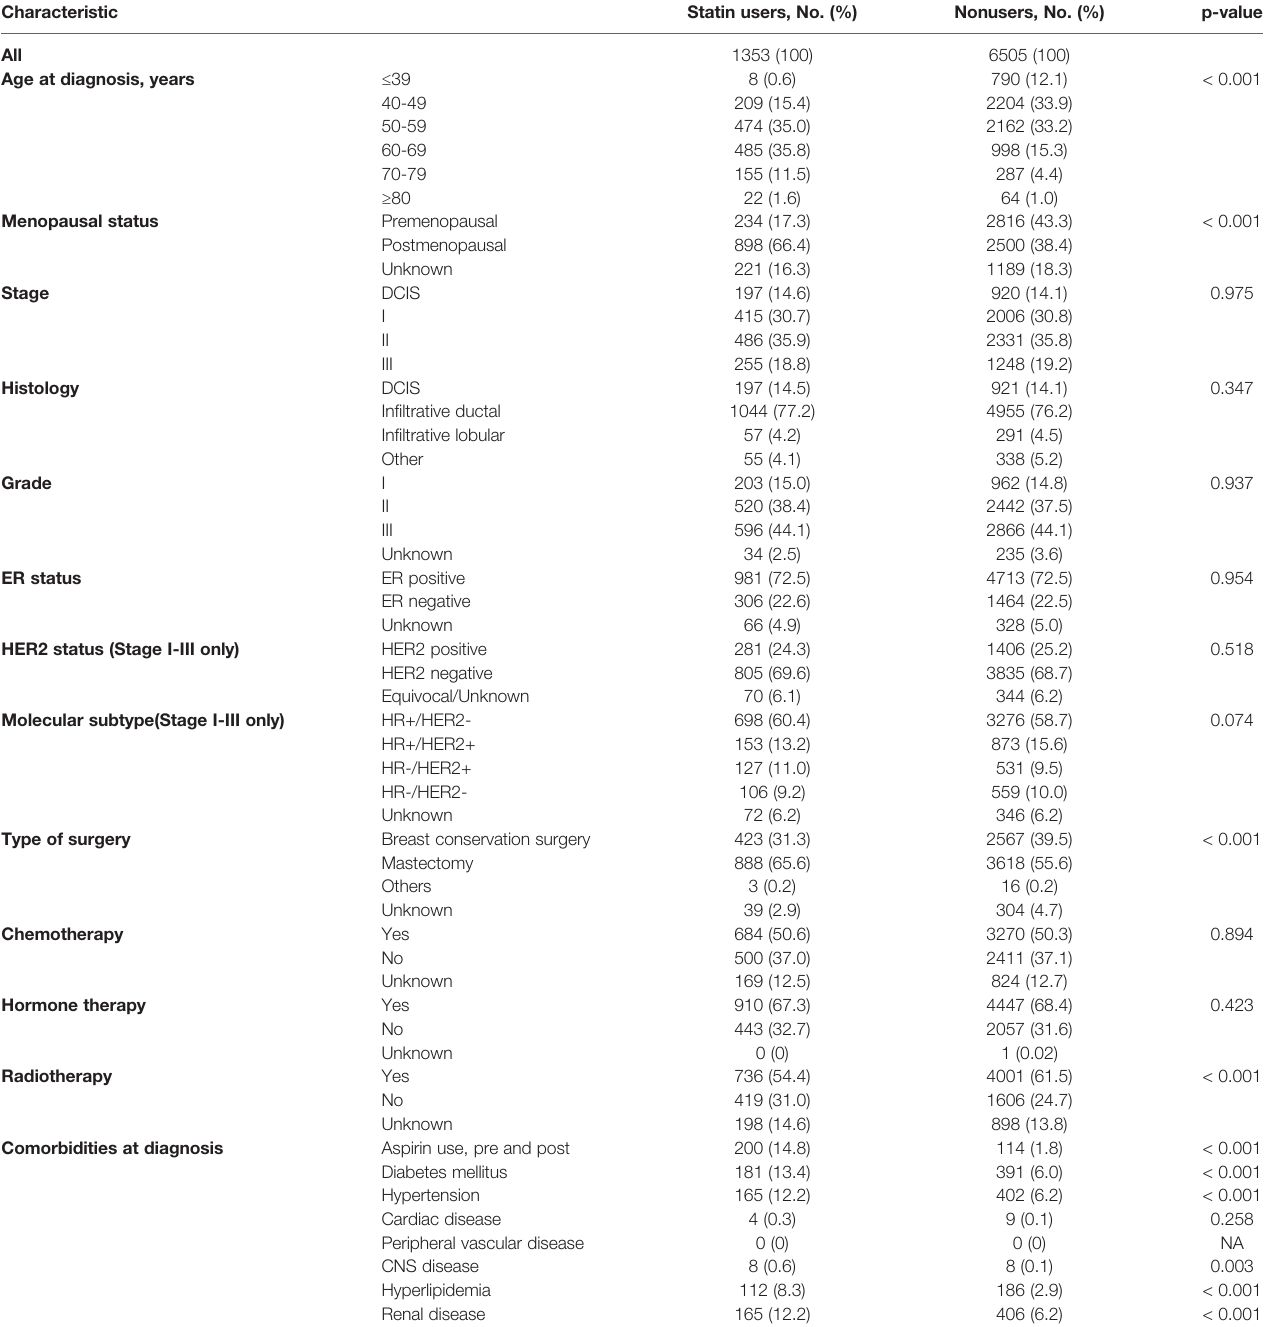
TABLE 1 | Patient and tumour characteristics by statin